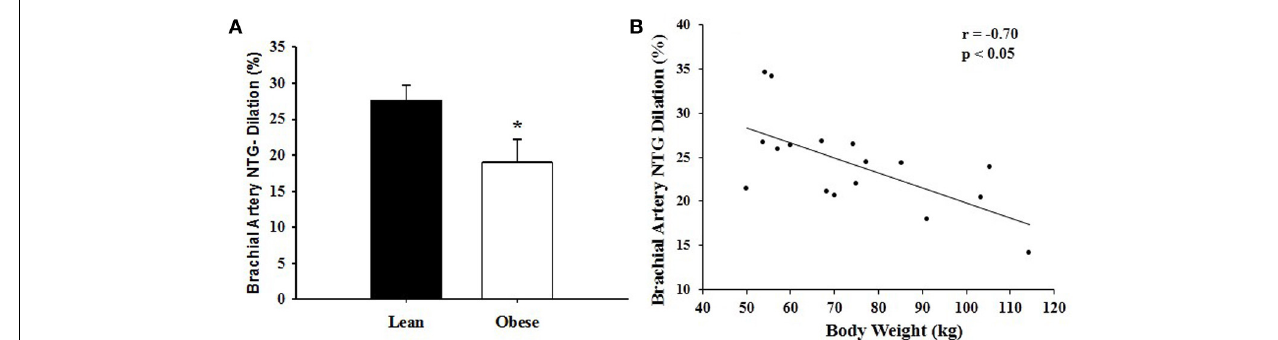
FIGURE 3 | (A) Nitroglycerin (NTG)-induced dilation of the brachial artery in lean (LN) and obese (OB) sedentary women after a single bout of strenuous weightlifting (SWL). *Significant difference observed in OB vs. LN ( p < 0 . 05). (B) Correlation between nitroglycerin (NTG)-induced